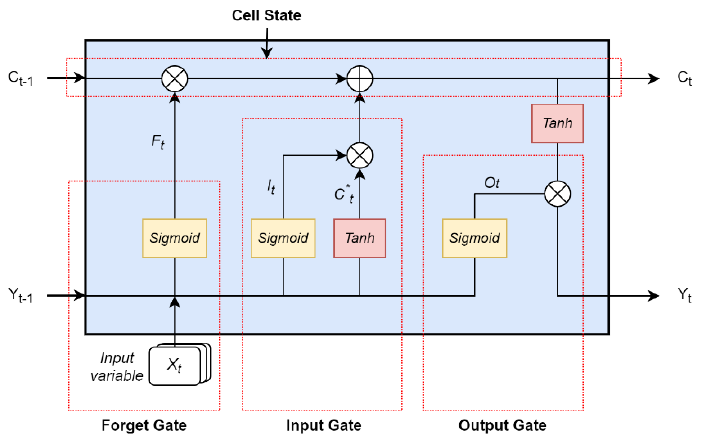
Figure 2. Diagram of the internal structure of an LSTM network.